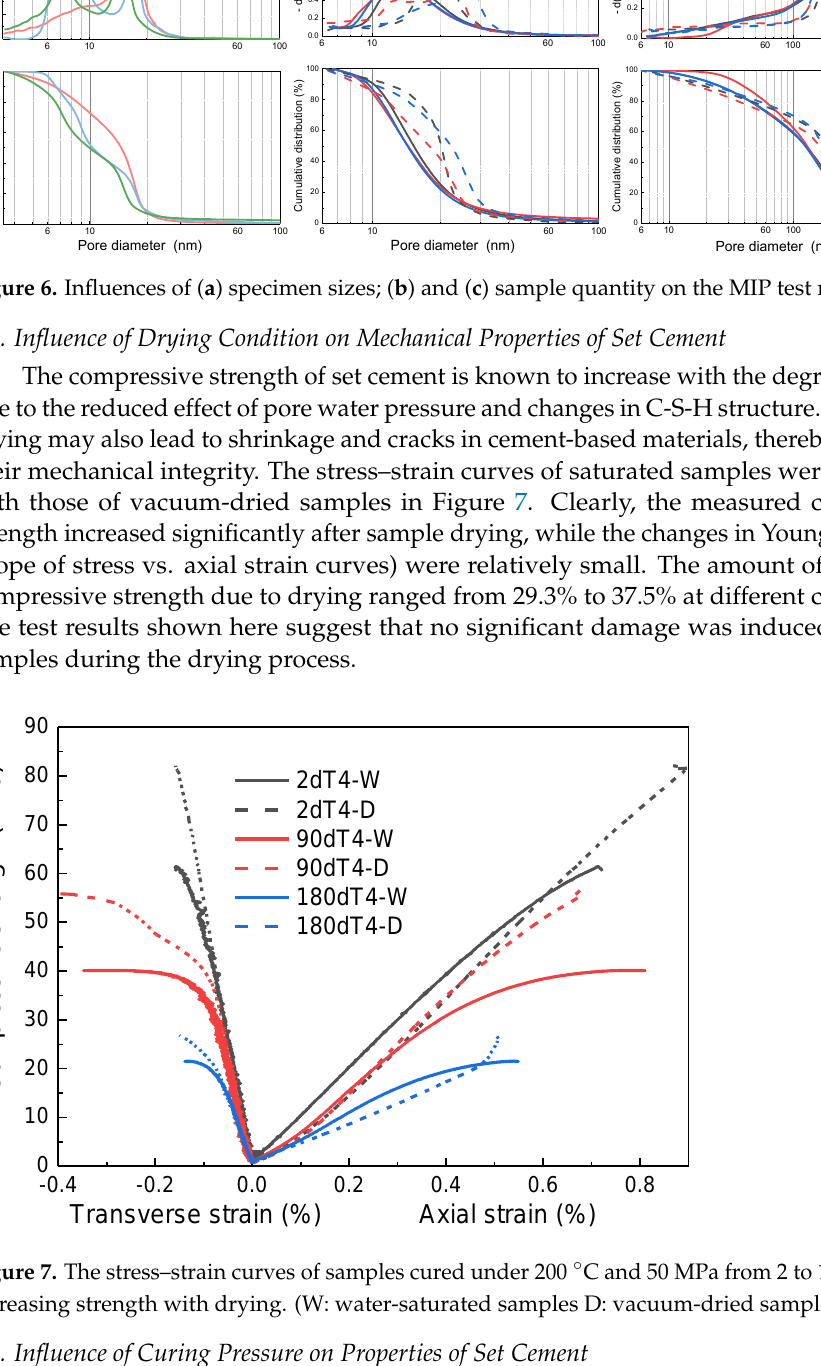
Figure 7. The stress–strain curves of samples cured under 200 °C and 50 MPa from 2 to 180 d showed increasing strength with drying. (W: water-saturated samples D: vacuum-dried samples).